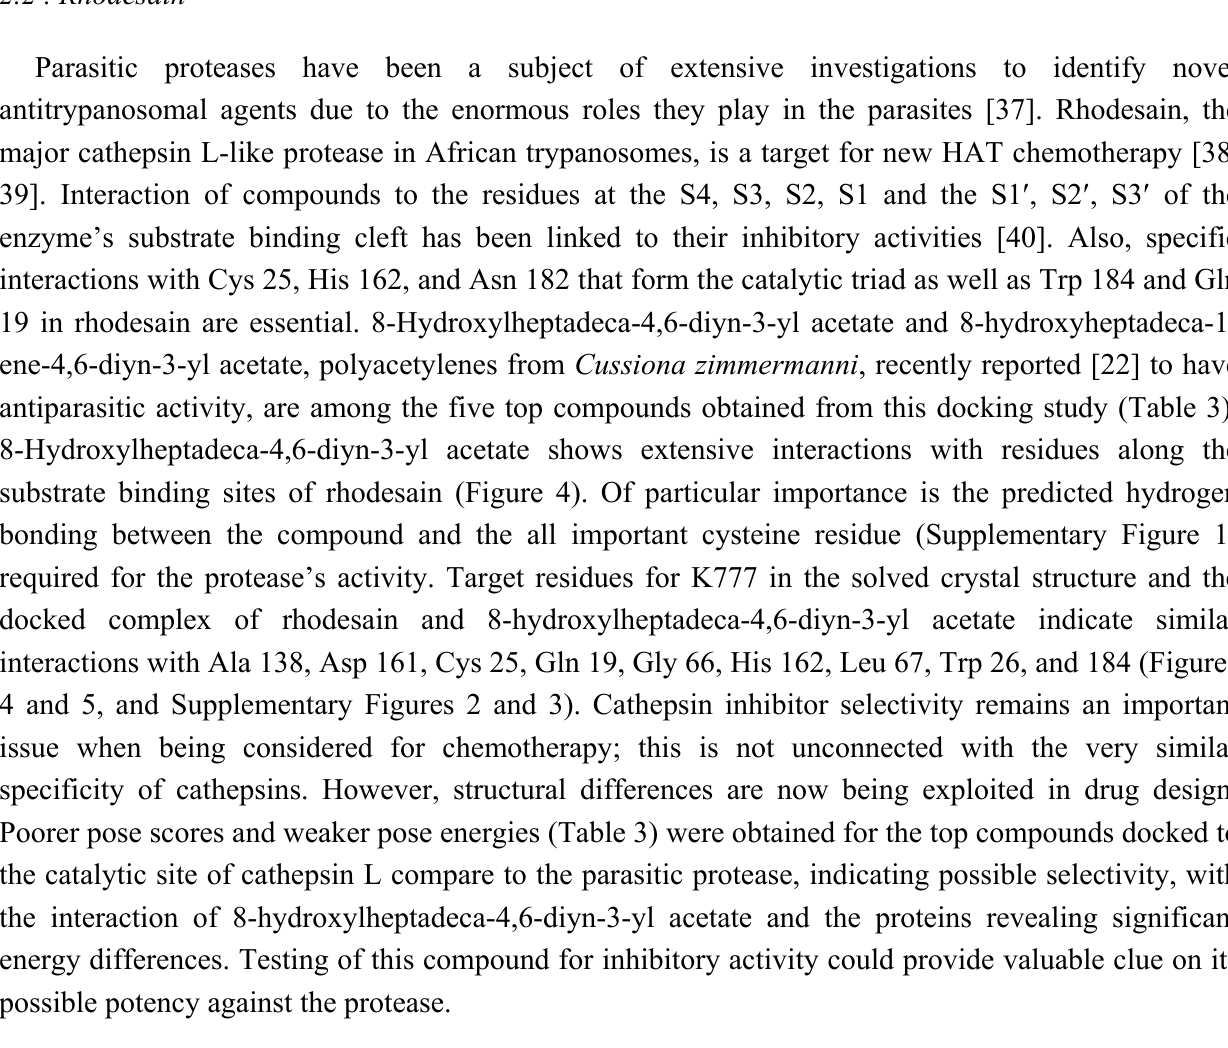
Table 3. Top hit compounds for docking to rhodesain and corresponding energy values for human cathepsin